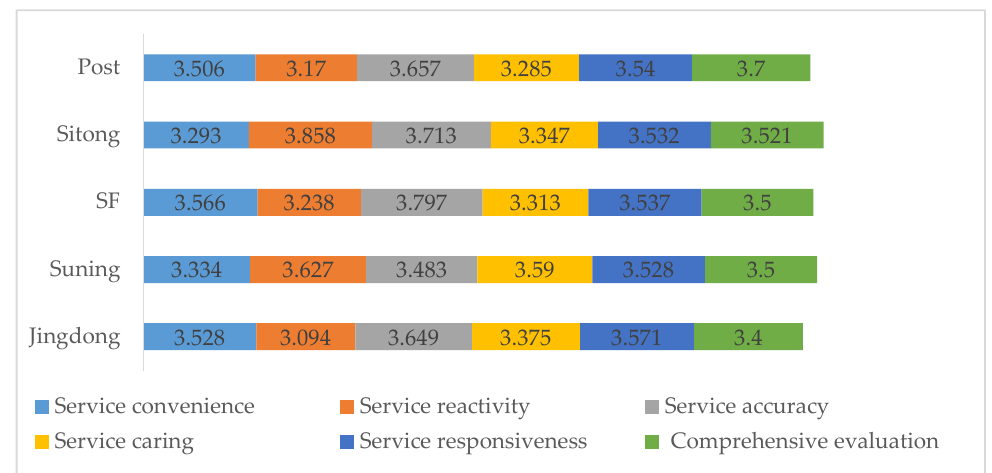
Figure 5. Adjacency matrix. Based on the transition law characteristics, the reachability matrix, R , was built as shown in Figure 6.